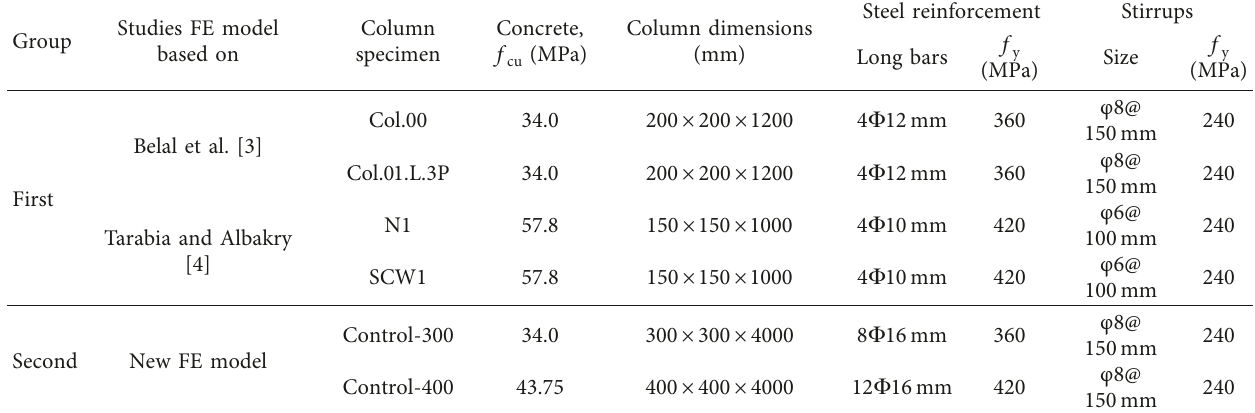
Table 1: A brief account of RC columns assessed in the current study using FE modeling.